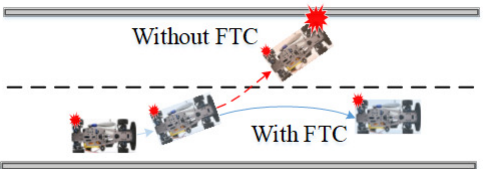
Figure 1. Scenarios of a skid steering vehicle’s fault. The red dashed line indicates the vehicle’s potential running path without FTC, which would cause a collision with nearby facilities. The blue line shows the expected vehicle driving path with FTC, which can avoid the collision